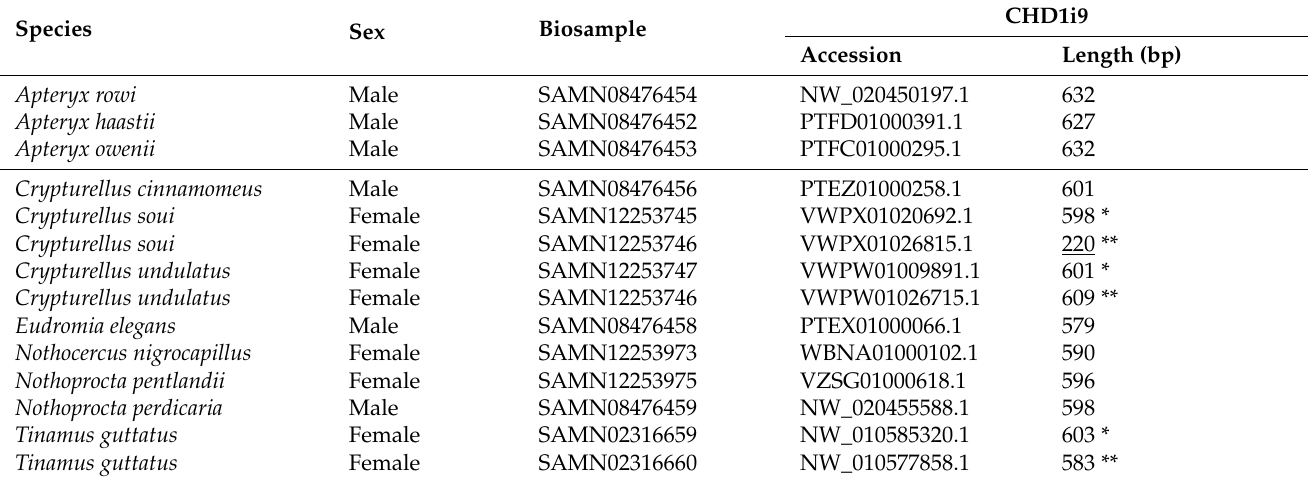
Table 2. Kiwi and Tinamous species analysed in this study in terms of length polymorphism of the ninth intron in the CHD1 gene. The accession numbers and length of the identified fragments are shown, as well as the assigned sex and biosample numbers. A single (*) or double (**) asterisk indicates different copies of the ninth intron in the CHD1 gene identified for Crypturellus soui , Crypturellus undulates , and Tinamus guttatus . A copy with only a partial sequence identified for Crypturellus toui is